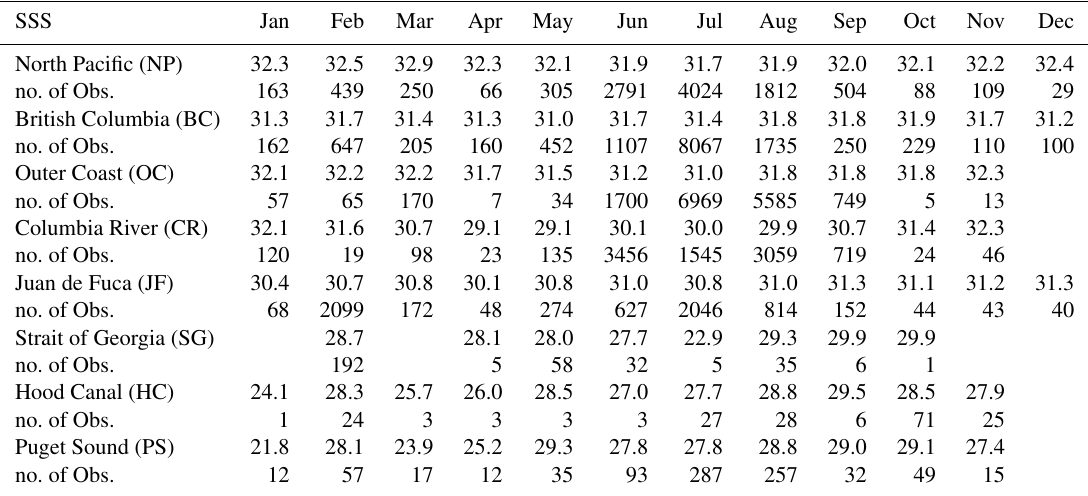
Table B1. Average monthly SSS seasonal cycles for the eight unique regions. The total number of observations (no. of Obs.) contributing to the monthly average estimate is included.